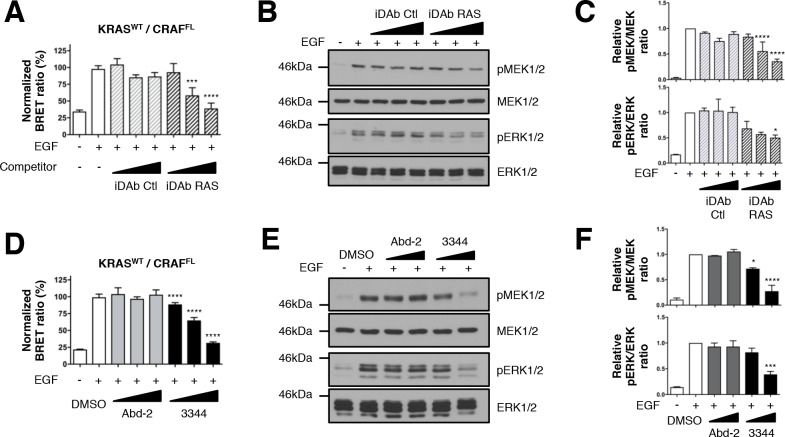
Wild-type KRAS and CRAF biosensor interaction-induced signaling is impaired by 3344.The BRET KRASWT/CRAFFL pair was tested for interaction after EGF stimulation of HEK293T cells in presence of competitors. In A, cells were transfected with plasmids to express the KRASWT biosensor with or without iDAbs and stimulated by EGF (50 ng/mL). iDAb RAS shows an inhibition of KRASWT/CRAFFL interaction after EGF treatment in a dose-dependent manner. B is a western blot of the transfected cells from panel A showing the effect of the iDAbs on EGF-stimulated RAS-RAF-MEK-ERK signaling pathway (pMEK and pERK signals are quantified in C). β-actin loading control, iDAbs and BRET pair expression controls are shown in Figure 3—figure supplement 1. The effect on BRET2 signal of compounds Abd-2 (grey bars) and 3344 (black bars) on KRASWT/CRAFFL interaction after EGF treatment in a BRET competition experiment is shown in panel D. In panel E, HEK293T cells were transfected as in D with the plasmids expressing the BRET pair KRASWT/CRAFFL for 24 hr and serum starved 20 hr in the presence of DMSO, 10 and 20 μM of Abd-2 and 3344 compounds. Cells were treated 5 min with EGF (50 ng/mL), lysed and analyzed by western blot. The expression level of the BRET protein pair is shown in Figure 3—figure supplement 1 as well as the loading control β-actin for the western blot. The western blot data are quantified in panel F. One-way ANOVA followed by Dunnett’s post-hoc tests were used to determine the statistical significance of BRET, pERK and pMEK modulations induced by the compound or the iDAb (*p<0.05, ***p<0.001, ****p<0.0001). Each experiment was repeated twice (B–C) or three times (A, D–F). Where error bars are presented, they correspond to mean values ± SD of biological repeats (A, D) or correspond to mean ±SEM of biological repeats (C, F). See also Figure 3—figure supplement 1.